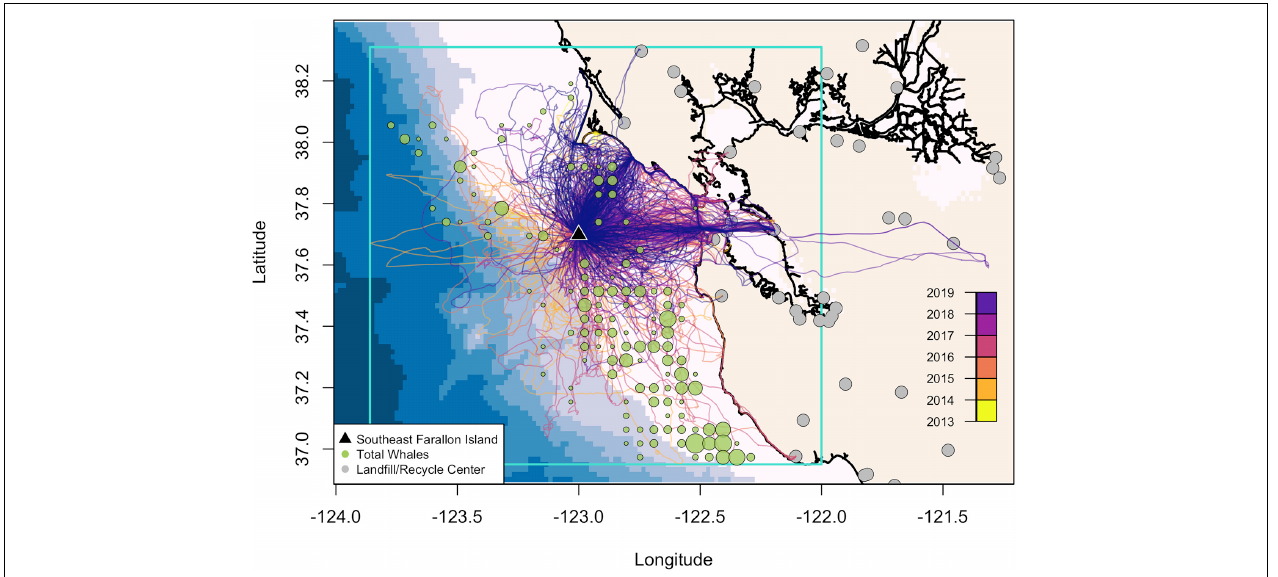
FIGURE 2 | Map of western gull tracks from 2013 to 2019 from their breeding colony on Southeast Farallon Island, east of the San Francisco Bay, California, United States (inset). The blue box is the study region. The total number of humpback whale sightings (summed on a 5 km × 5 km grid) from 2013 to 2019 from the Rockfish Recruitment and Ecosystem Assessment Survey where the size of the circle is scaled from 1 to 23 individuals. Note, the survey did not equally cover our entire study area. Landfill or recycling center locations are denoted in gray and bathymetry is shown in the background from 0 to 3,800 m depth in ∼ 600 m